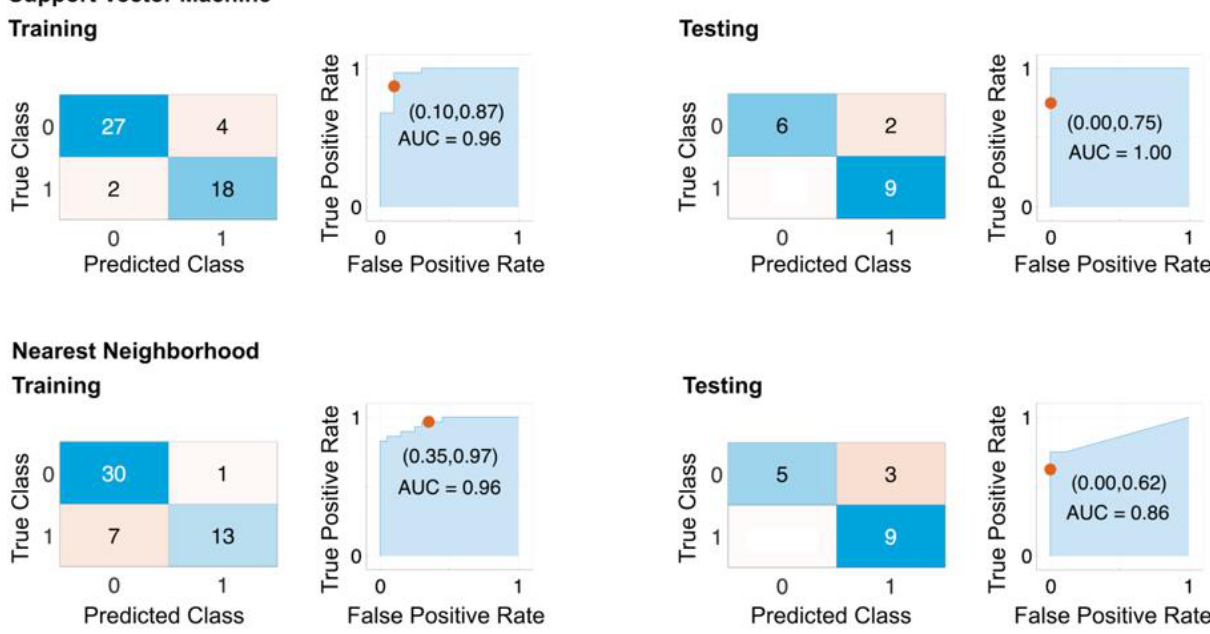
Figure 6. Performance of selected features on original dataset. The confusion matrix and ROC plots for training and testing of best-performing models based on HIF5_avg and HIF50_avg features with 10-fold cross-validation. The dataset includes all rat strains except Dll4+, Dll4 − , CG4 − , and CG5+. An amount of 25% of the dataset was used for holdout testing. Top row: SVM model. Bottom row: Nearest Neighborhood .